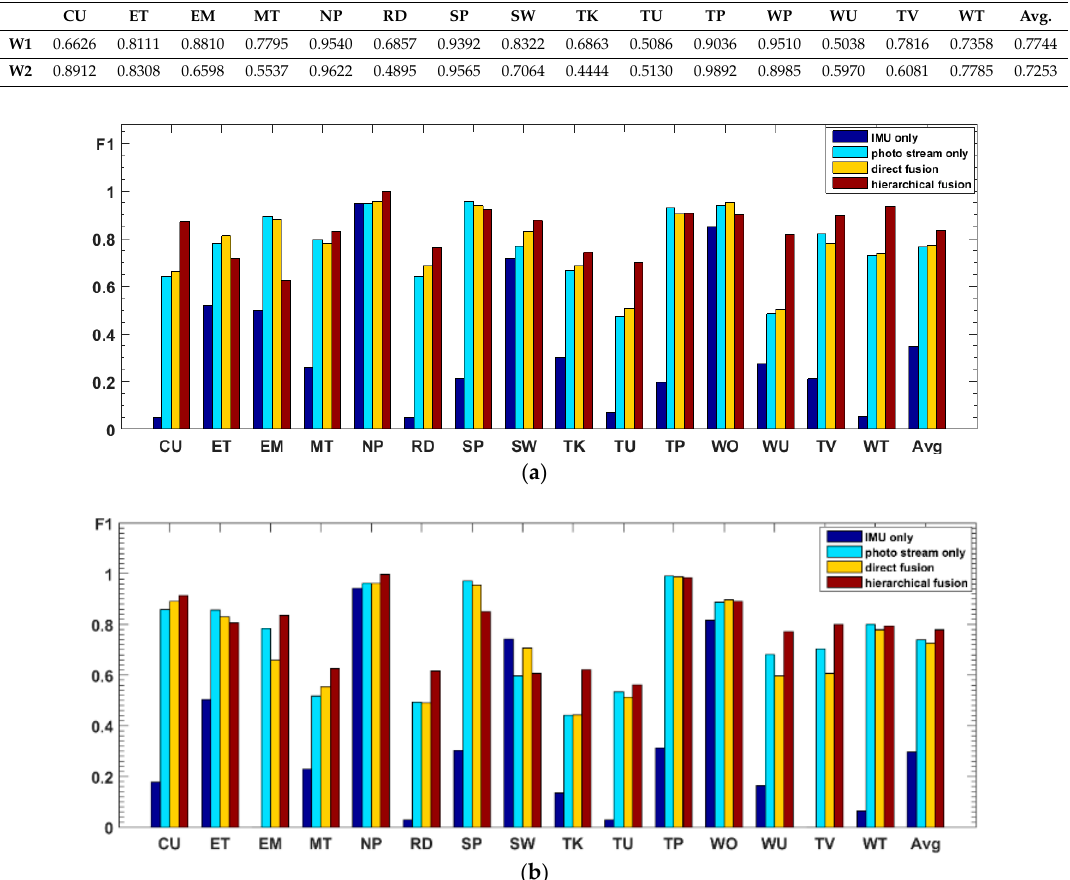
Figure 19. F 1 accuracies of four methods shown as bar graphs for ( a ) W1 and ( b ) W2.